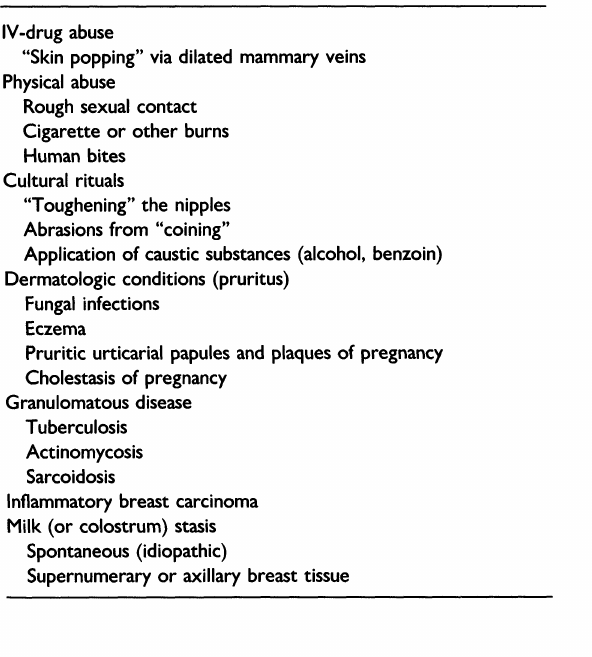
TABLE I. Possible causes and predisposing